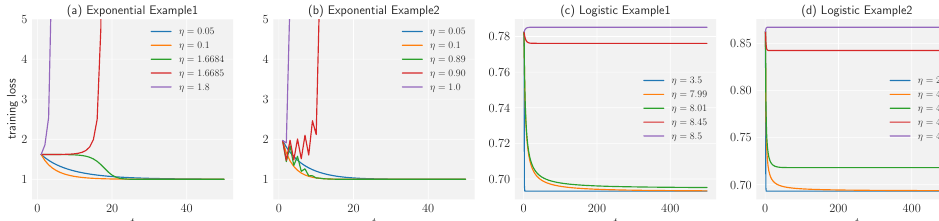
Figure 2. Showing the dependence of the dynamics of the training loss on the learning rate for linear predictors using both exponential and logistic loss functions. Examples 1 and 2 were used to test the performance of the linear predictors. The sub-graphs ( a , c ) show the experimental learning curves for separable data, consistent with the theoretical predictions. The critical learning rates were found to be η critical = 1.66843 and η critical = 8.485 for the exponential and logistic loss functions, respectively. Sub-graphs ( b , d ) show the dynamics of the training loss for non-separable data. The dynamics of training loss regarding the learning rate for non-separable data are similar to those of degenerate cases. Hence, the critical learning rates can be approximated by η critical = 0.895 and η critical = 4.65,